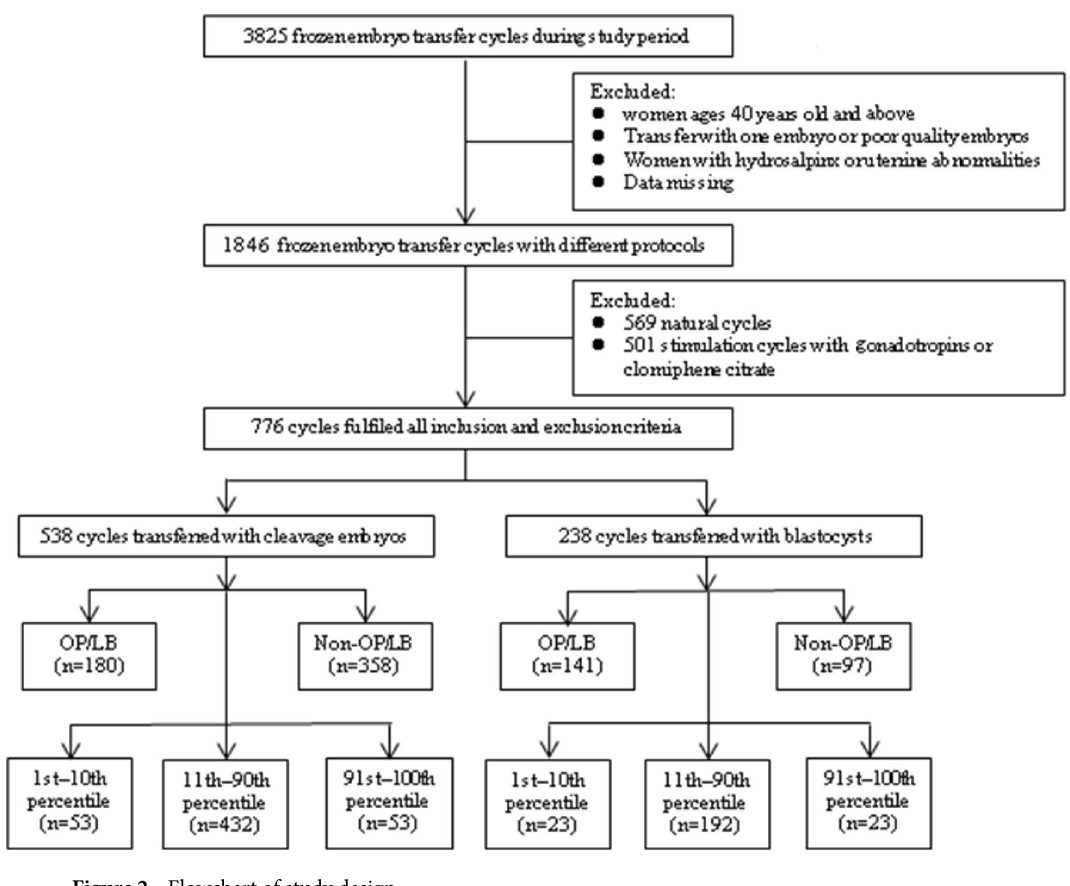
Figure 2. Flowchart of study